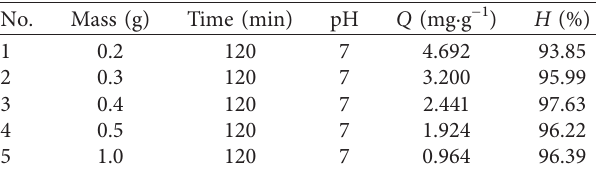
Table 10: Effect of adsorbent weight on methylene blue adsorption process.